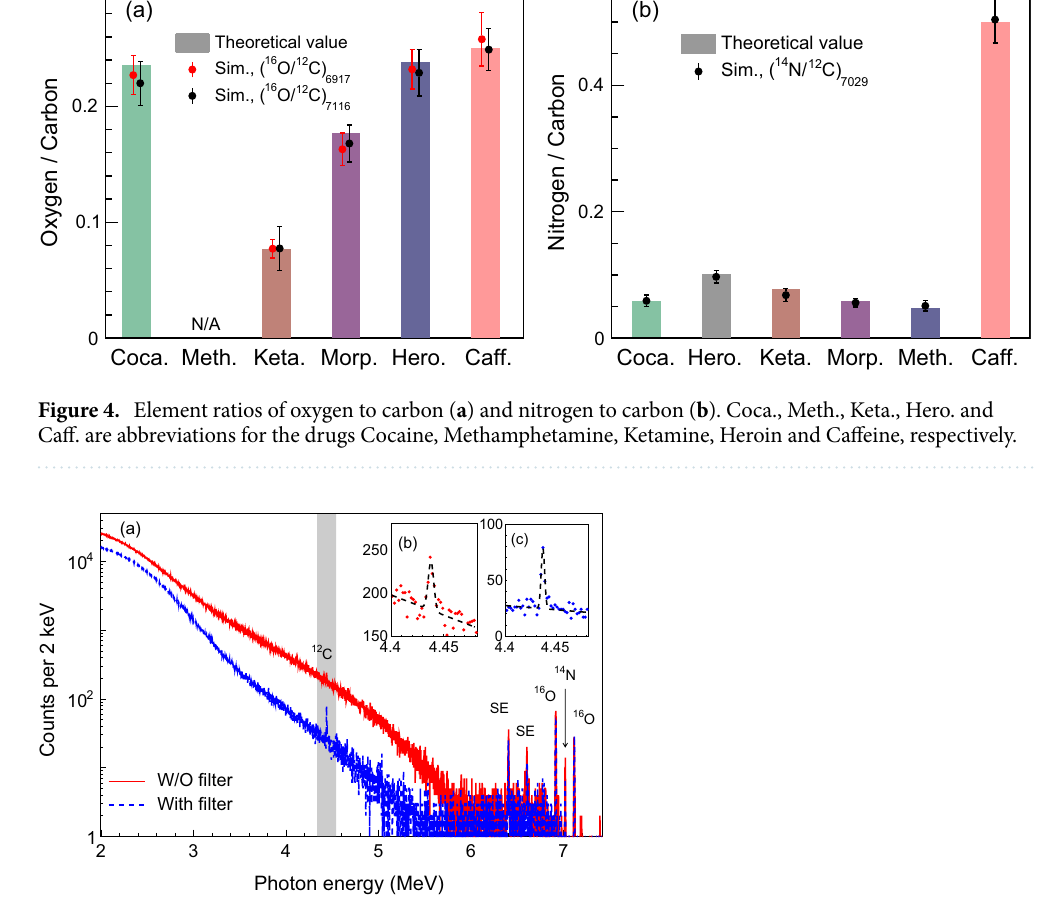
Figure 5. ( a ) Simulation result of energy spectrum merged from four HPGe detectors with / without 1-mm-thick lead filter. The insets show enlarged views of the shadow area: ( b ) and ( c ) are the the 4438-keV line and its fit curve for 12 C in the absence and presence of lead filter, respectively. A 15-mm-thick iron material is used to conceal the drug